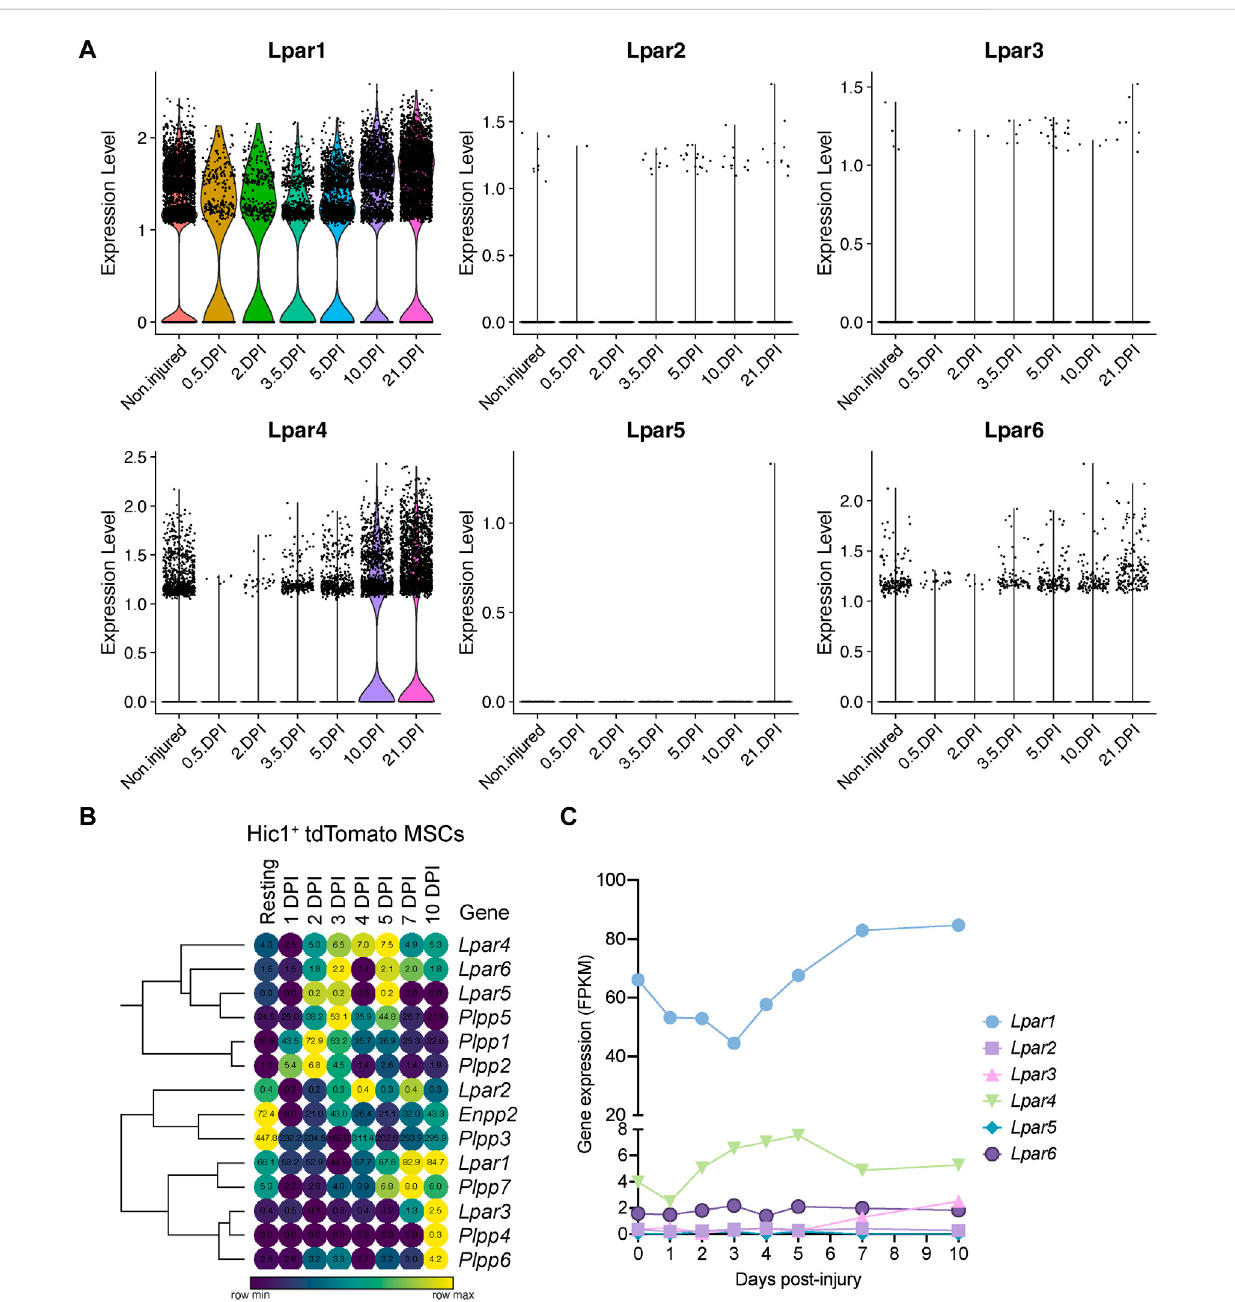
FIGURE 4 Muscle injury triggers a fast and strong downregulation LPA receptors in fi bro-adipogenic progenitors. (A) Violin plots showing the gene expression levelofLPARfamilymembersanddynamicsinresponsetoinjury.DPI,Dayspost-injury. (B) Heatmapshowinggeneexpressionlevelsof Lpar , Enpp2 ,and Plpp genes in Hic1 + tdTomato expressing cells upon acute muscle damage (Scott et al., 2019). (C) Quanti fi cation of Lpar (FPKM) in Hic1 + tdTomato expressing cells and dynamics in response to injury.